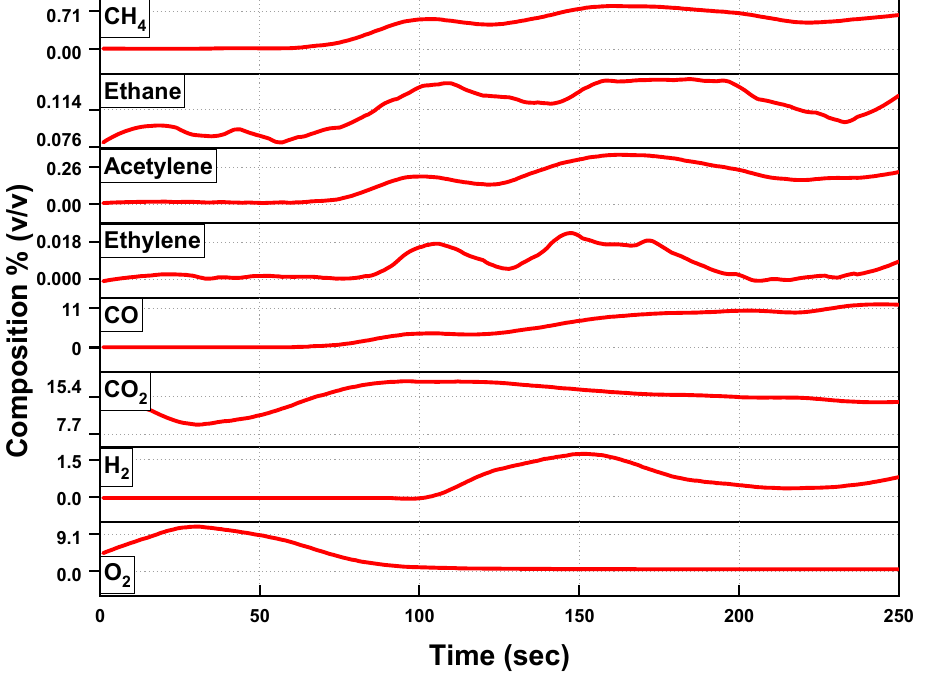
Figure 7. Gas yield composition as a function of gasification temperature at the theoretical equivalence ratio of 0.48 ± 0.05 for ( A ) flame retardant cotton and ( B ) 0.46 ± 0.02 after flame retardant substrate removal.